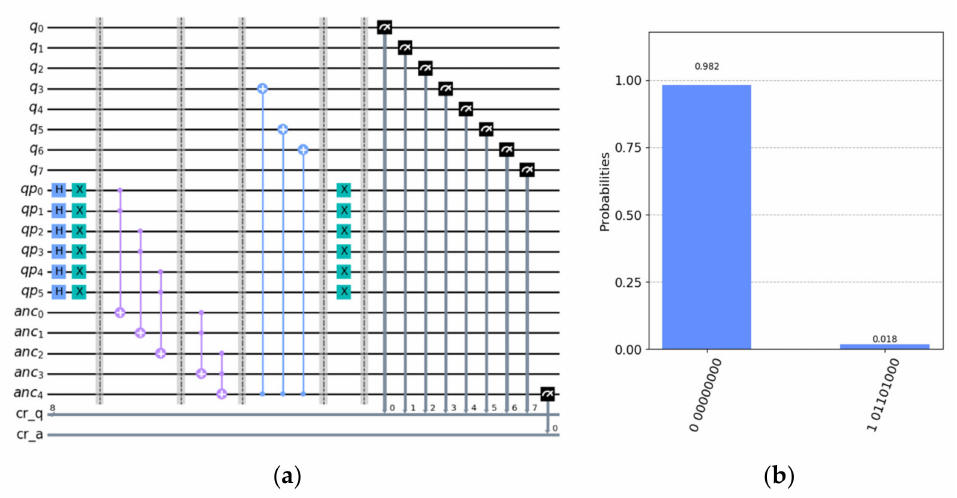
Figure 3. ( a ) NEQR representation for gray level 104 and ( b ) results on the local simulator. The probability difference is due to the fact that there is only one combination out of a maximum of 64, for the position qubits, where all 6 qubits are in state | 1 (cid:105) (immediately after the Hadamard and NOT gates).